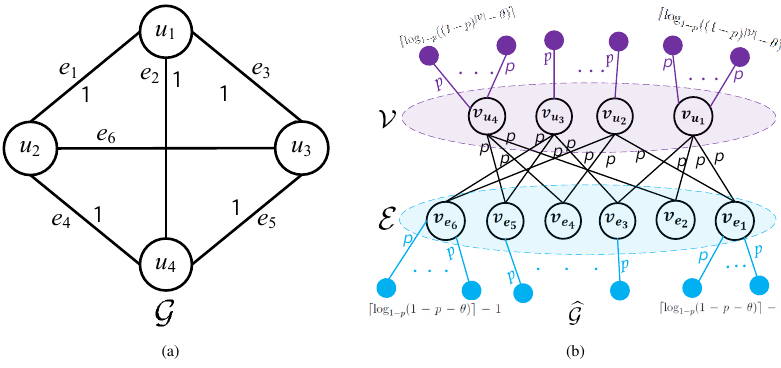
Fig. 2 Illustration of the construction from GG to b GG